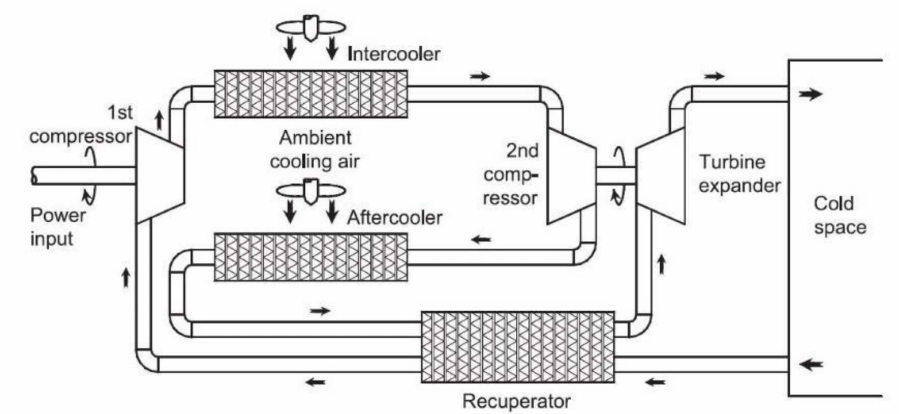
Figure 22. Schematic layout of a typical air cycle system with two stage compression. Copyright (2004), with permission from